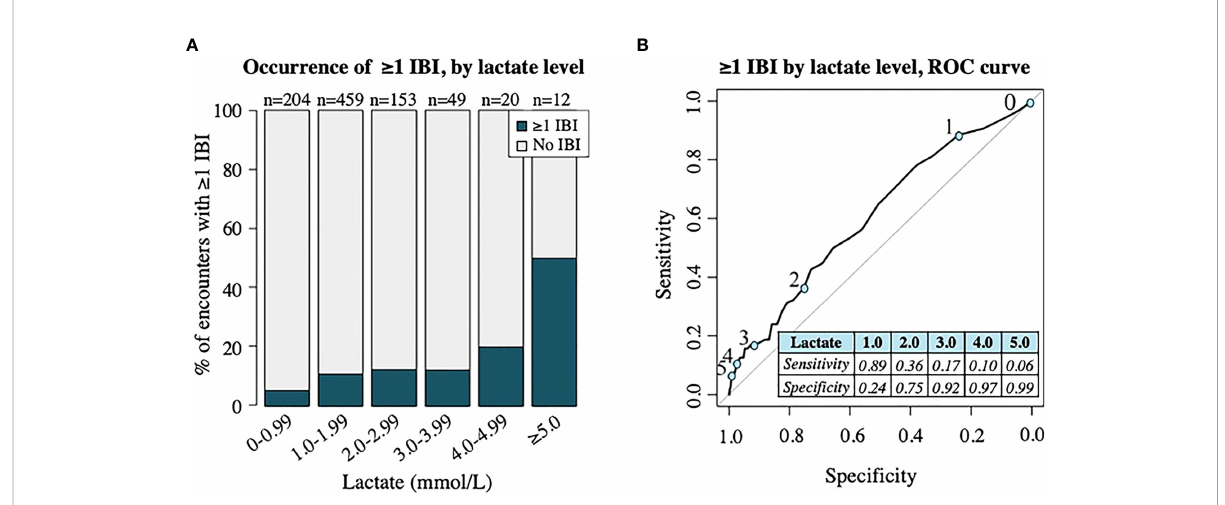
FIGURE 4 Analysis of invasive bacterial infection (IBI) by lactate level. (A) Proportion of patient encounters with occurrence of ≥ 1 IBI by lactate level in increments of 1 mmol/L. Numbers (n) on top of bars signify the total number of patient encounters with initial lactate level in speci fi ed range. (B) ROC curve demonstrating association of lactate level with occurrence of one ≥ 1 IBI. Numbers 0-5 along ROC curve represent ROC curve points (blue circles) for lactate level cutoffs in mmol/L, shown in table. Area under the curve =